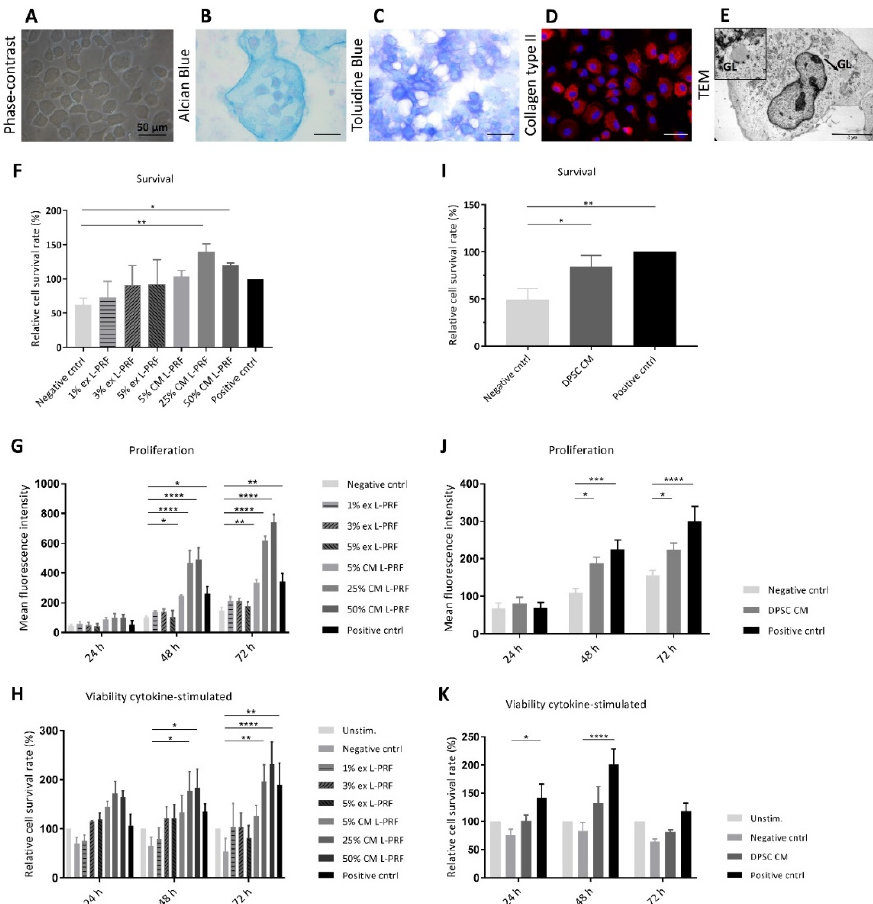
Figure 2. Phenotypic characterization of immature murine articular chondrocytes (iMACs) and the e ff ect of L-PRF ex, L-PRF CM and DPSC CM on iMAC survival, proliferation and chondrocyte viability in TNF- α - and IL-1 β -stimulated conditions. ( A ) Phase contrast micrographs of mouse iMACs show a rounded, polygonal morphology. ( B – D ) Histological staining revealed the production of sulphated PGs, while immunofluorescence staining demonstrated collagen type II expression. ( E ) Transmission electronmicroscopy(TEM)showedarounded, sphericalmorphologywithabundantroughendoplasmic reticulum, mitochondria and glycogen-rich (GL) vacuoles (insert). The e ff ect of the secretome of L-PRF and DPSCs on unstimulated iMAC survival, proliferation and cytokine-stimulated iMAC viability were evaluated by means of a PI assay ( F – K ). ( F ) 25% and 50% L-PRF CM had a significant pro-survival e ff ect on iMACs after 24 h compared to the negative control ( n = 5). ( G ) 5%, 25% and 50% L-PRF CM had a significant proliferative e ff ect on iMACs after 48 h and 72 h compared to the negative control ( n = 4). ( H ) 25% and 50% L-PRF CM significantly increased the viability of TNF- α - and IL-1 β -stimulated iMACs after 48 h and 72 h ( n = 5 for 24 h, n = 6 for 48 h, n = 6 for 72 h). ( I ) DPSC CM had a significant pro-survival e ff ect on iMACs after 24 h compared to the negative control ( n = 8). ( J ) DPSC CM significantly increased the proliferation of iMACs after 48 h and 72 h ( n = 7 for 24 h, n = 8 for 48 h, n = 9 for 72 h). ( K ) TNF- α - and IL-1 β -stimulated iMAC viability follows an increasing trend after exposure to DPSC CM, although not statistically significant. ( n = 8 for 24 h, n = 10 for 48 h, n = 8 for 72 h). Scale bars A, B, C and D = 50 µ m. Scale bar E: 5 µ m (original magnification: 5,600). Data are represented as mean ± S.E.M. * p ≤ 0.05. ** p ≤ 0.01. *** p ≤ 0.001. **** p ≤